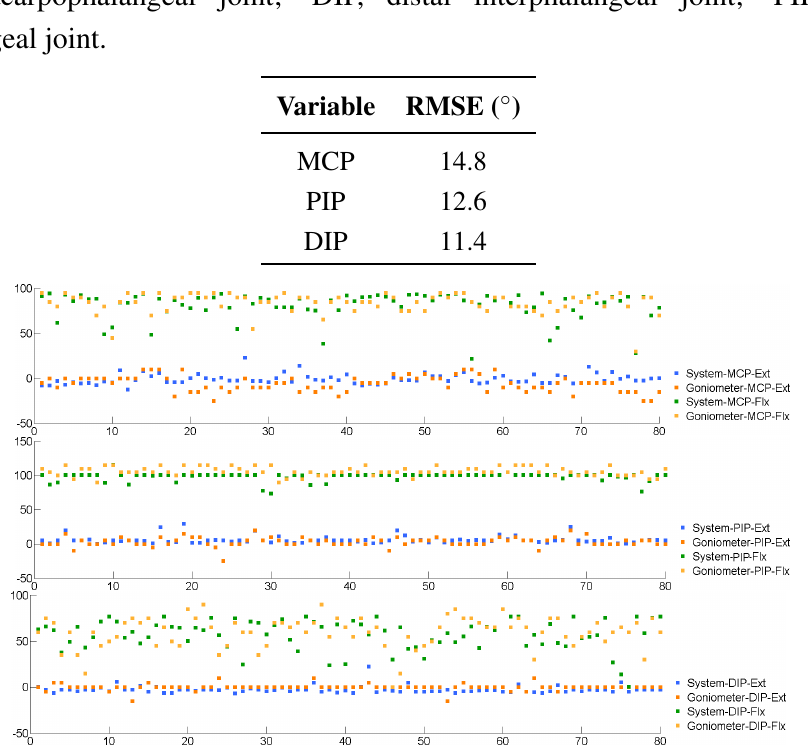
Figure 9. The ROM of MCP, PIP and DIP measured by the proposed system and a therapist. The values from 1–40 and from 41–80 on the x-axis are the left hands of 40 subjects and the right hands of 40 subjects,